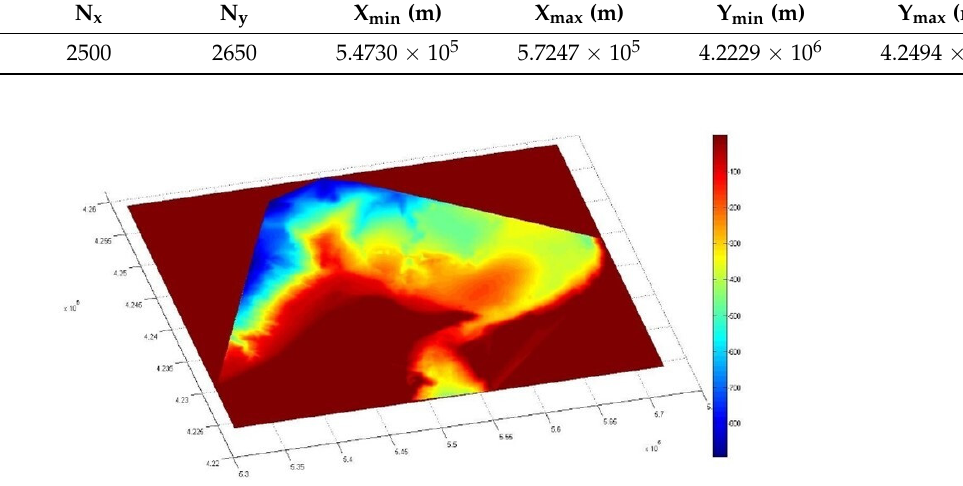
Figure 9. Two-dimensional plane view of meshgrid interpolating bathymetric data.